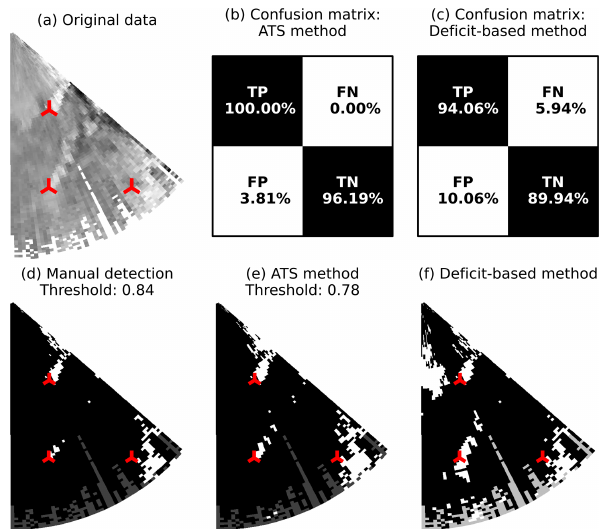
Figure 15. Scan 221 (aligned-wake subset), wake identification. (a) The original data in the Cartesian coordinates, (b, c) confusion matrices for the ATS and deficit-based methods, (d) manual thresh- old selected in a way to separate the two wakes, and (e, f) thresholds estimated by the ATS and deficit-based methods.